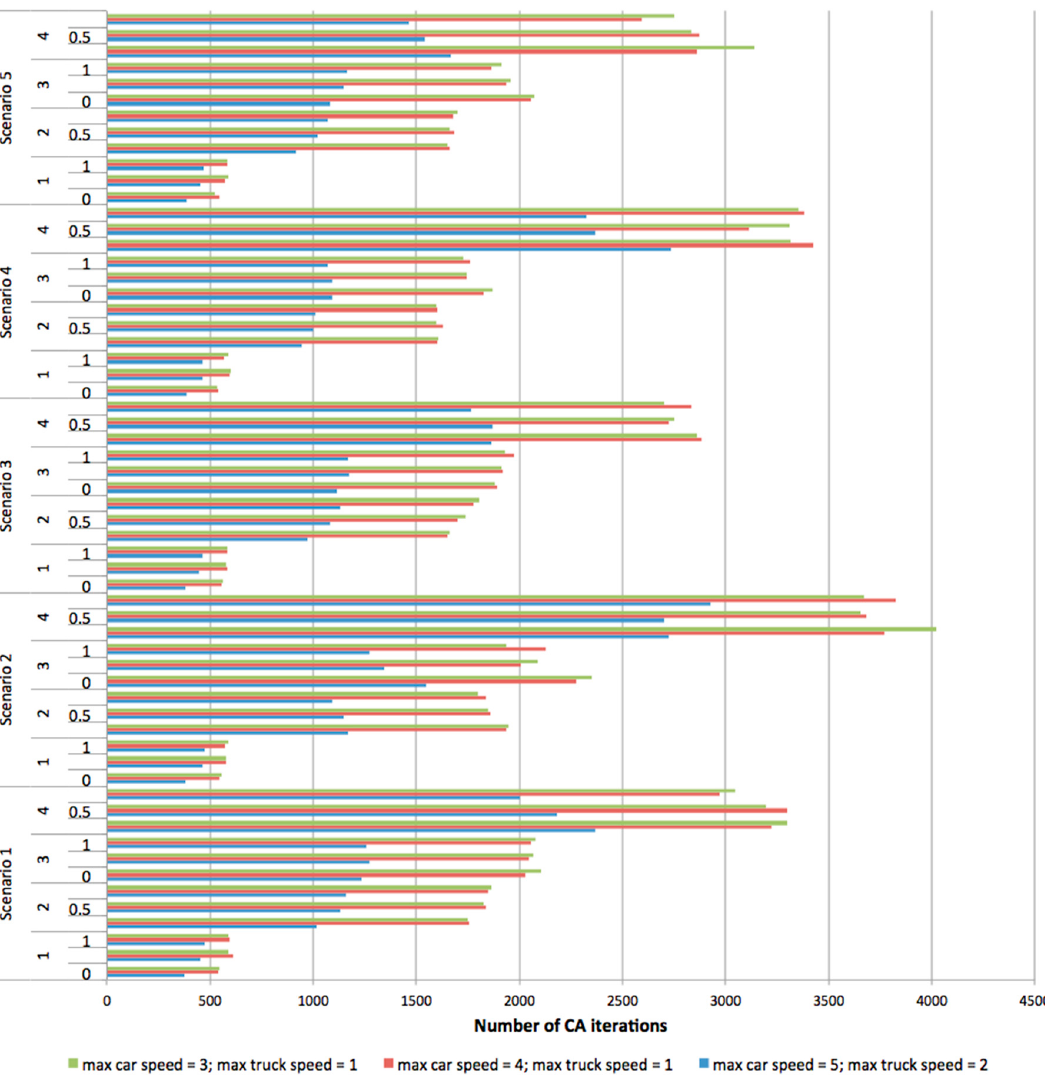
Figure 14. Impact of pedestrian traffic and distances between vehicles on roundabout capacity as per various traffic scenarios.